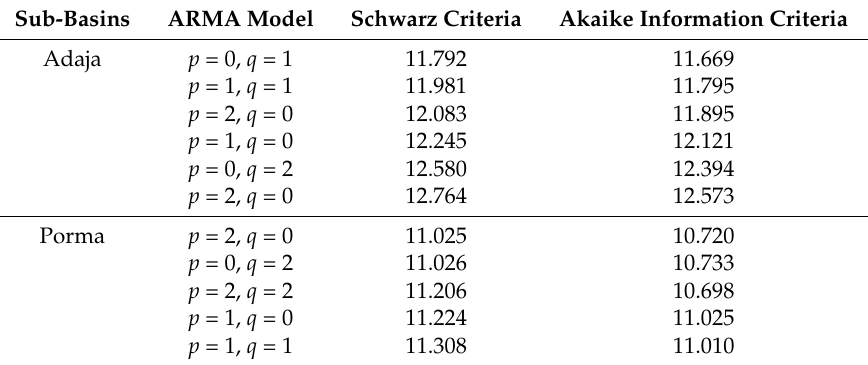
Table 2. Suitability identification of time order through ARMA modelling. Note: Results ordered according to Schwarz Criteria.